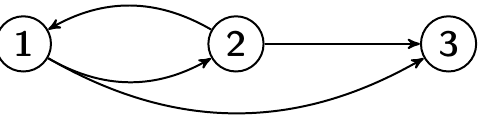
Figure 1. Possible transitions for an insured person’s process in an income protection insurance with K { = the three states 1 = healthy,2 = sick/unfit for work,3 = death